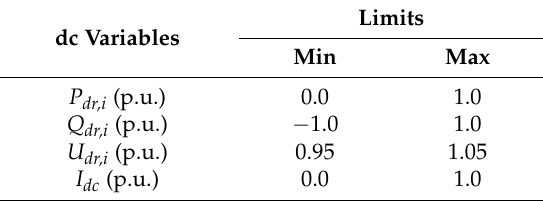
Table 3. DC-link variables